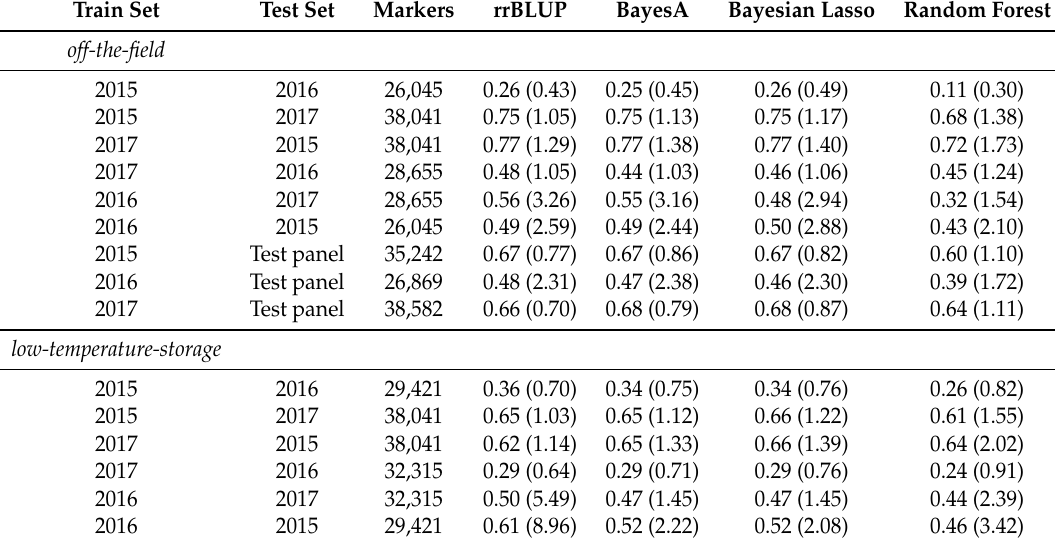
Table 4. Predictive ability for fry color ‘off-the-field’ and after long-term storage at 4.5 ◦ C using various combinations of training and testing sets and four statistical models (bias is shown in brackets). Train Set Test Set Markers rrBLUP